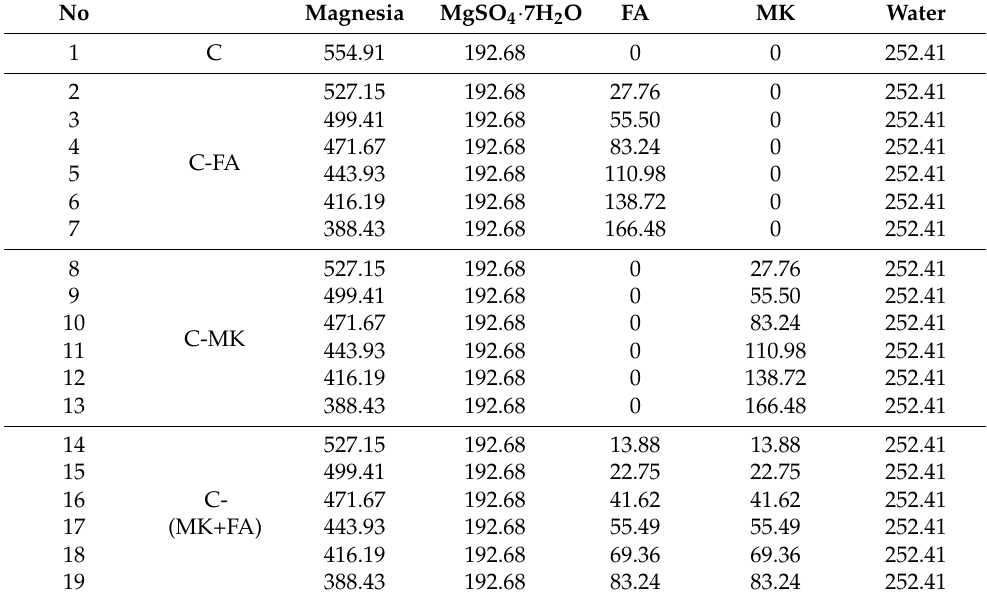
Table 2. The total mass of raw materials was 1000 g. Table 2. The mix proportion of MOSC Table 2. The mix proportion of MOSC (g).